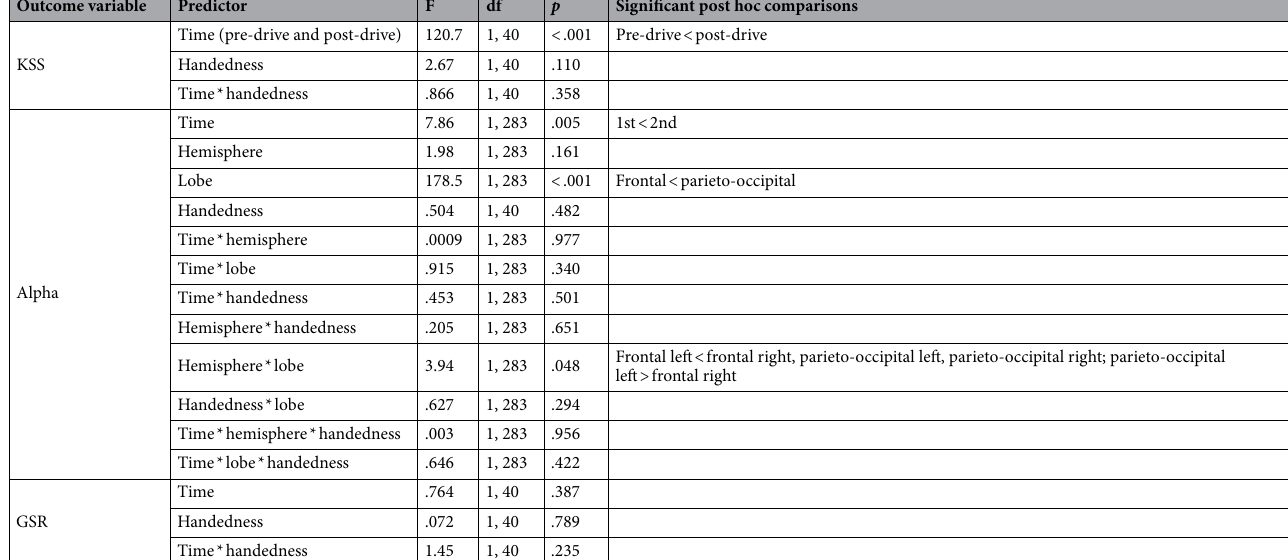
Table 1. F values, degrees of freedom, p values and holm corrected post hoc comparisons with corrections relative to time-on-task and handedness, for each KSS, Alpha and GSR from the mixed effects models. Hemisphere and lobe are additional predictors in the alpha model. LH = left-handers, RH = right-handers. Pre-D = pre-drive, post-D = post drive. For post hoc analyses < and > indicate the direction of the effect (e.g., 1st < 2nd refers lower levels of the outcome variable in the first half compared to second half of drive). Only relevant post hoc comparisons reaching statistical significance ( p < .05) following corrections for